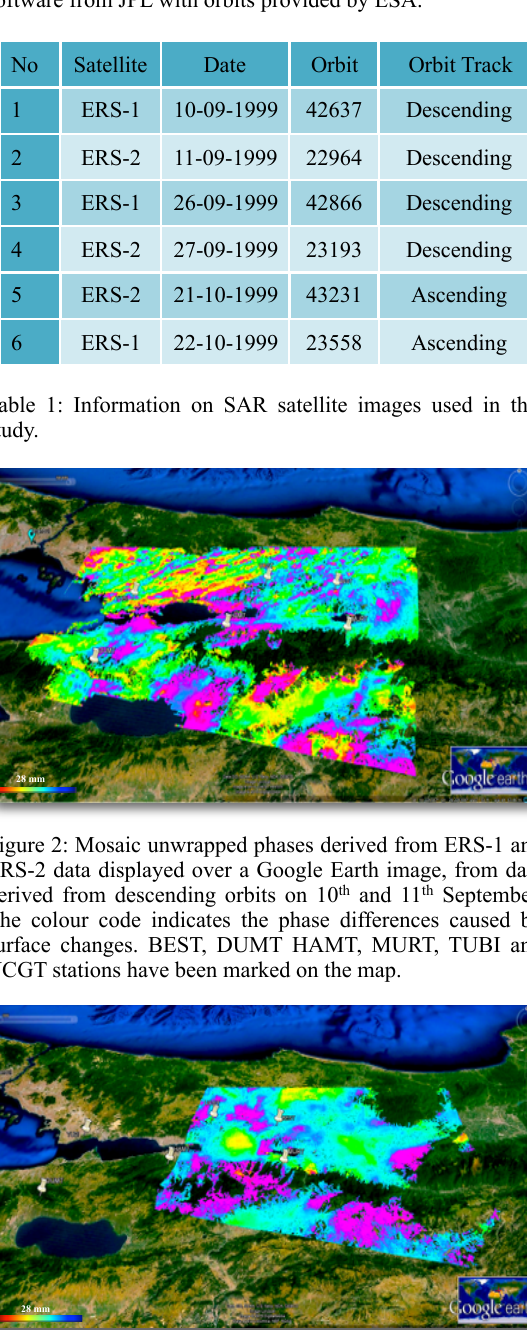
Figure 3: Unwrapped phases derived from ERS-1 and ERS-2 data displayed over a Google Earth image from data derived from descending orbits on 26 th and 27 th September. The colour code indicates the surface changes. BEST, DUMT HAMT, MURT, TUBI and UCGT stations have been marked on the